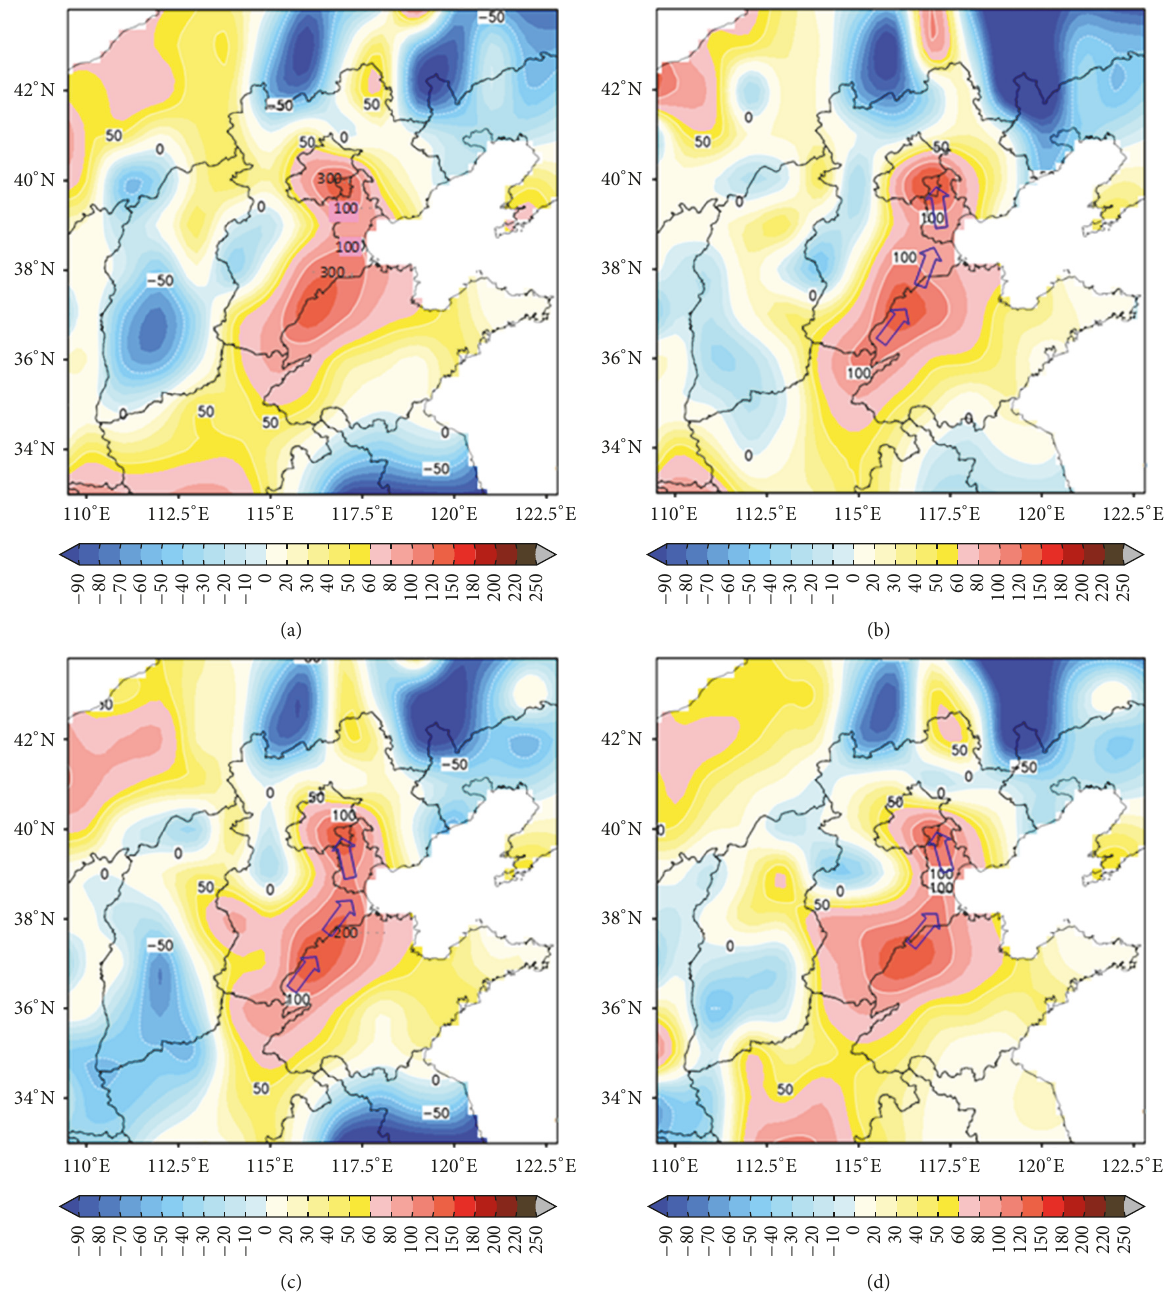
Figure 4: PLAM → BJ index distribution in weather conditions on isentropic surface (280 ∘ k) at 08:00 on 20 December 2016 and 3 h (b), 6h (c), and 12 h (d) high-resolution predictions of pollution transports oriented to Beijing from its surrounding areas. Initial time: 08:00 on 19 December; (a)–(d) are 1h, 3 h, 6 h, and 12h predictions.